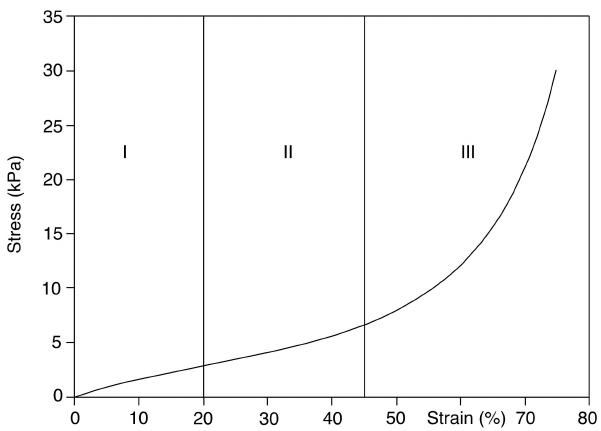
Figure 1. A typical compression curve for a foamed elastomeric material where ( I ) is the initial region with larger tangent modulus, ( II ) is the buckling region with the reduced tangent modulus, and ( III ) is the densification